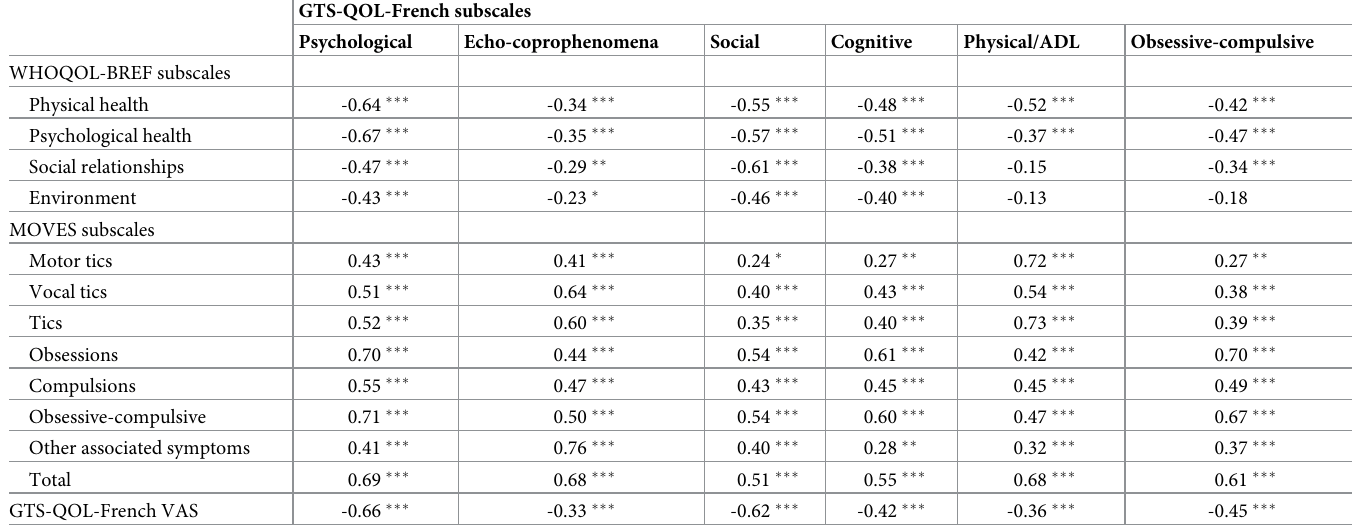
Table 7. Spearman’s correlation coefficients between the GTS-QOL-French and the WHOQOL-BREF, the MOVES, the GTS-QOL-French VAS